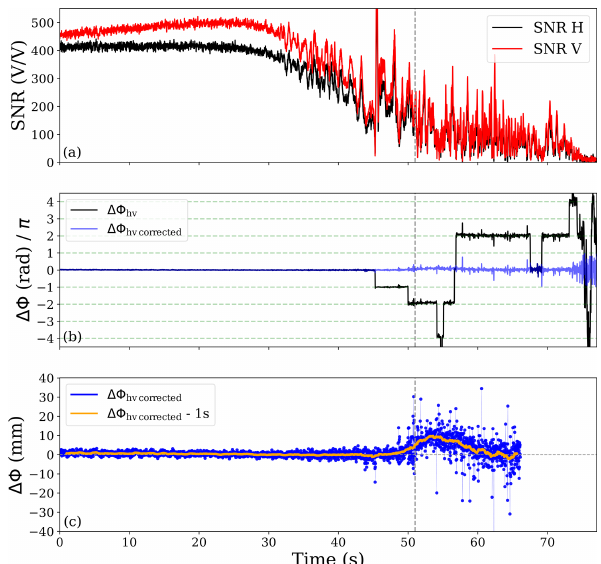
Figure 2. Example of one polarimetric RO observation, correspond- ing to ID 20180827_2108paz_gps57. The RO tangent point is lo- cated at 46.5 ◦ N, 165.3 ◦ E. (a) SNR for H (black) and V (red) ports as a function of time. (b) Raw differential phase shift between the H and V excess phase observables (black) and the same observ- able after being corrected for cycle slips, following the procedure in Sect. 2.1. Notice that before the CL to OL transition (gray ver- tical line), there are two half-cycle slips (jumps of π ), while af- ter the transition, several full-cycle slips (jumps of 2 π ) appear. (c) Corrected differential phase shift (blue) and the corresponding 1s smoothed measurement (simple average running window). In the bottom part, the differential phase shift is truncated where the corresponding retrieval